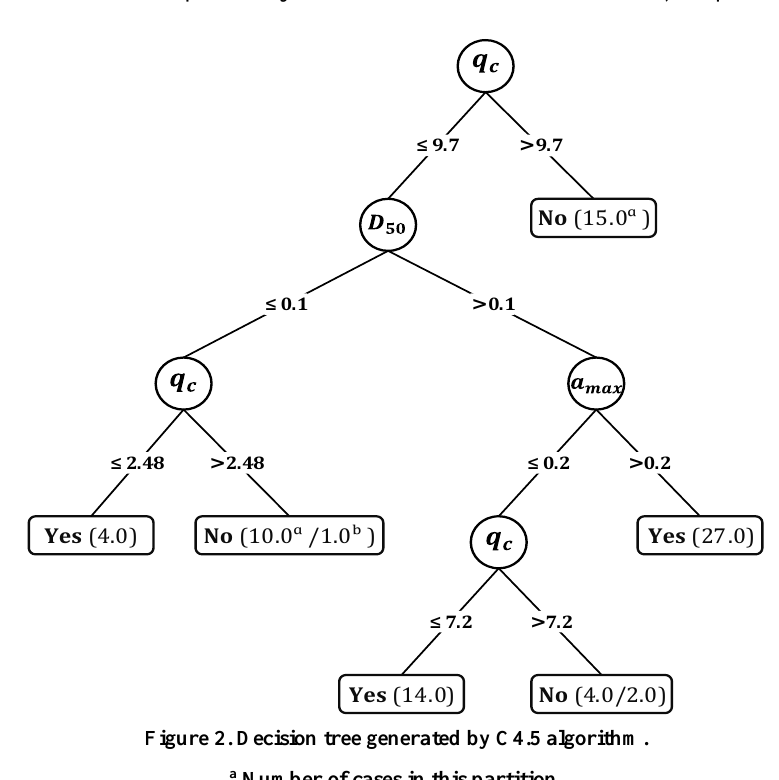
Figure 2. Decision tree generated by C4.5 algorithm.